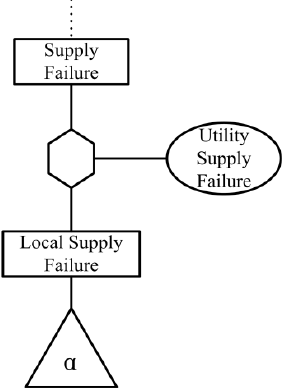
Figure 2. Logical operation connecting the two layers of fault